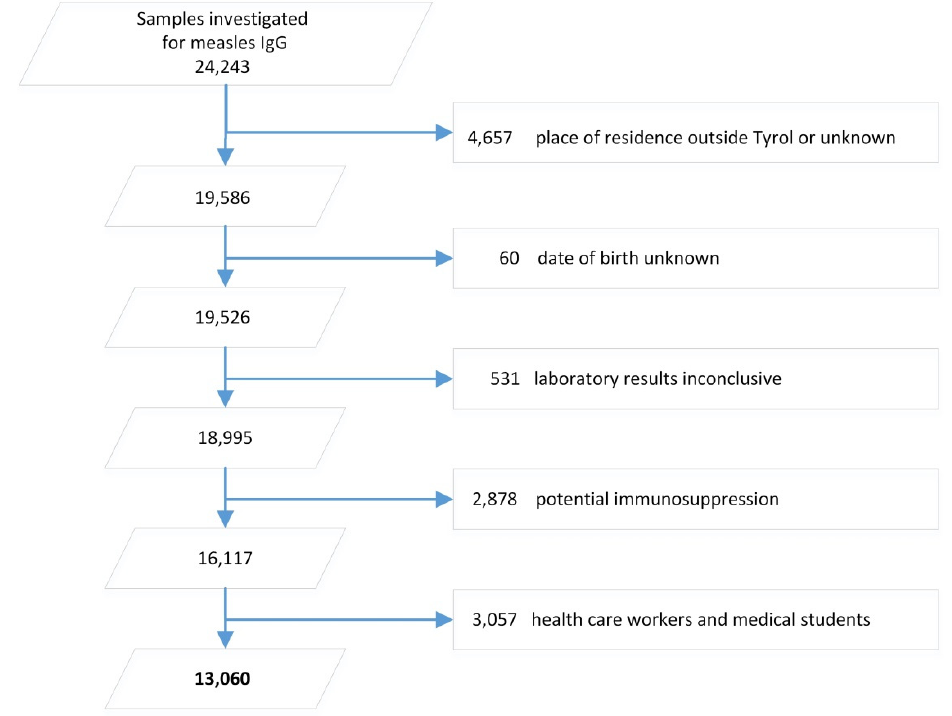
Figure 1. Sample size of investigated patient samples in Tyrol, 1997–2016 and final sample size for analysis after application of inclusion and exclusion criteria.